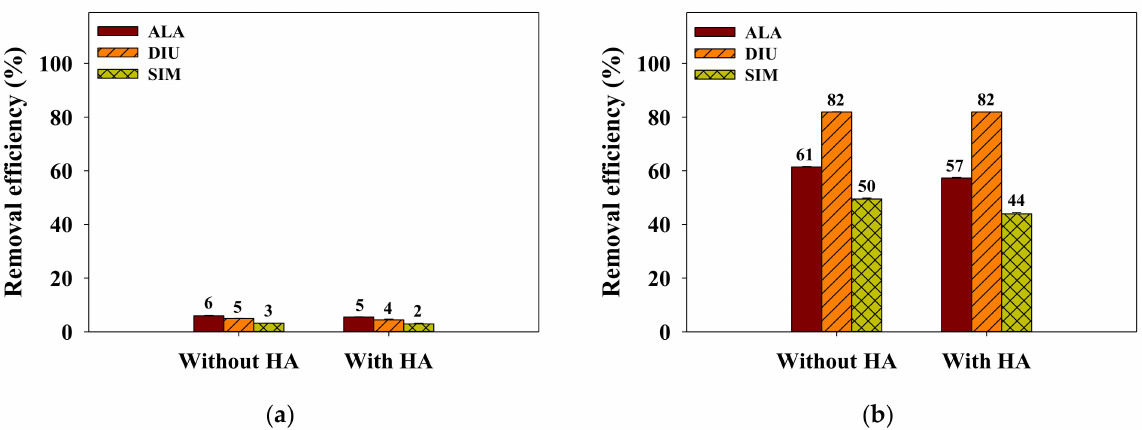
Figure 10. The effects of humic acids on the removal of the herbicides by ( a ) the GCRB and ( b ) GCRB-N (concentration of humic acids = 5 mg/L, agitation speed = 150 rpm, contact period = 24 h, absorbent dosage = 50 mg/L, initial concentration of each herbicide = 10 µ M, pH 7, and temperature = 25